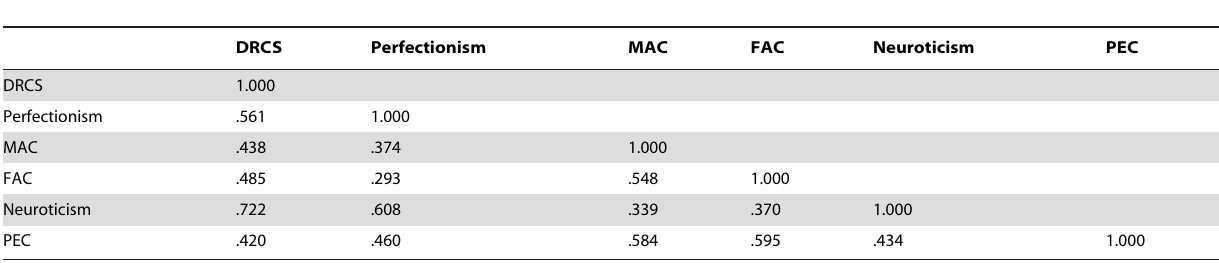
Table 6. Correlation Matrix of Latent